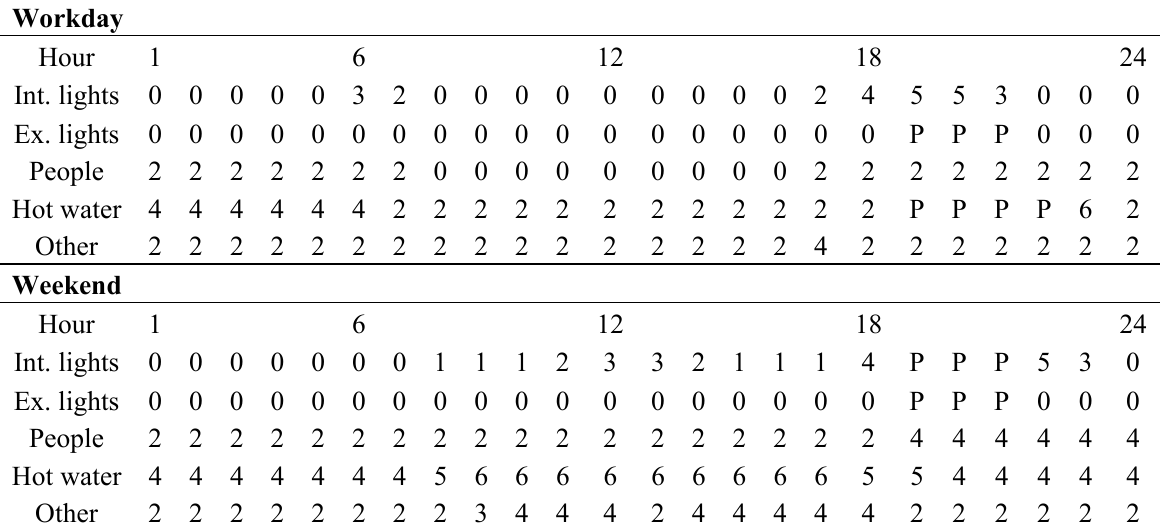
Table 3. Energy use profiles for typical workday and weekend day (Hour 1 = 1:00